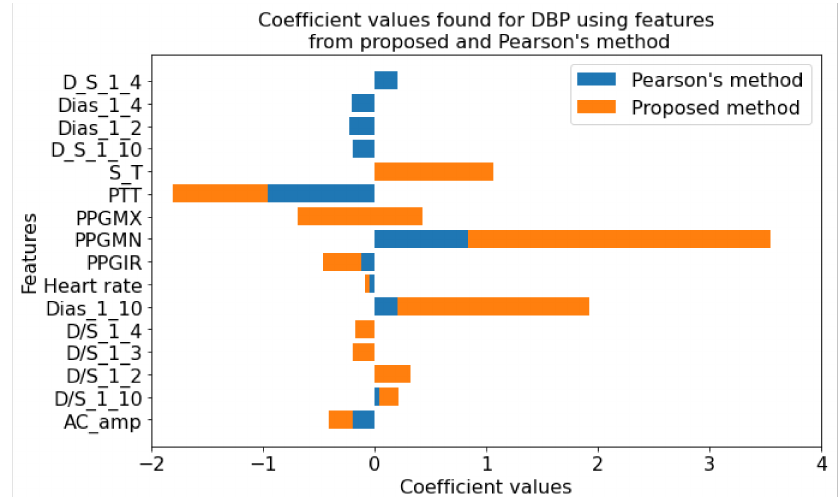
Figure 18. Coefficient values found for DBP using features from proposed method and Pearson’s method.